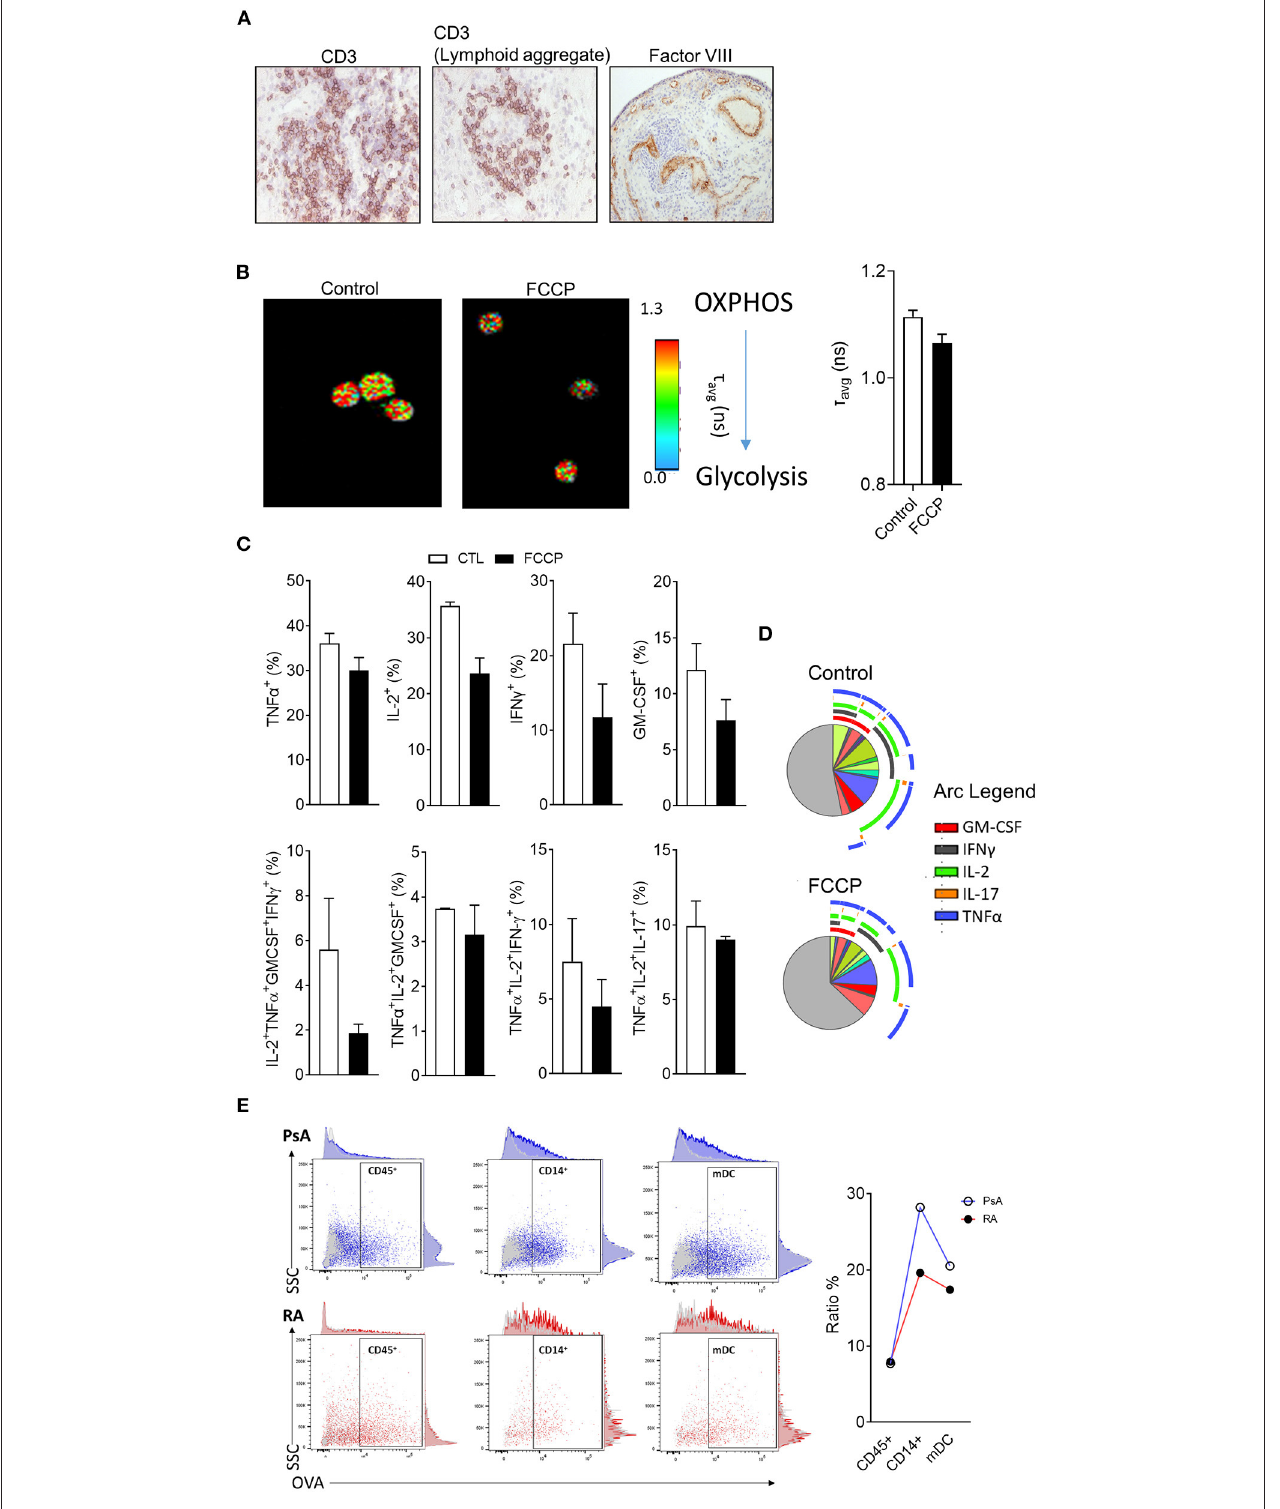
FIGURE 3 | Metabolic and functional characterization of synovial tissue cells. (A) Representative H&E analysis of RA patient synovial tissue biopsies for expression of CD3 or Factor VIII. (B) Representative fluorescent lifetime imaging microscopy (FLIM) of synovial tissue cell suspension at baseline or following treatment with